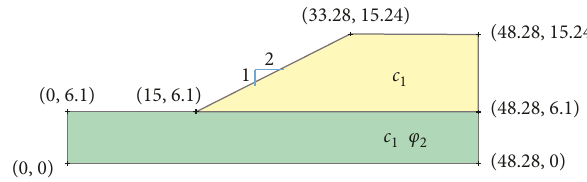
Figure 3: Geometry of slope for Example 2.